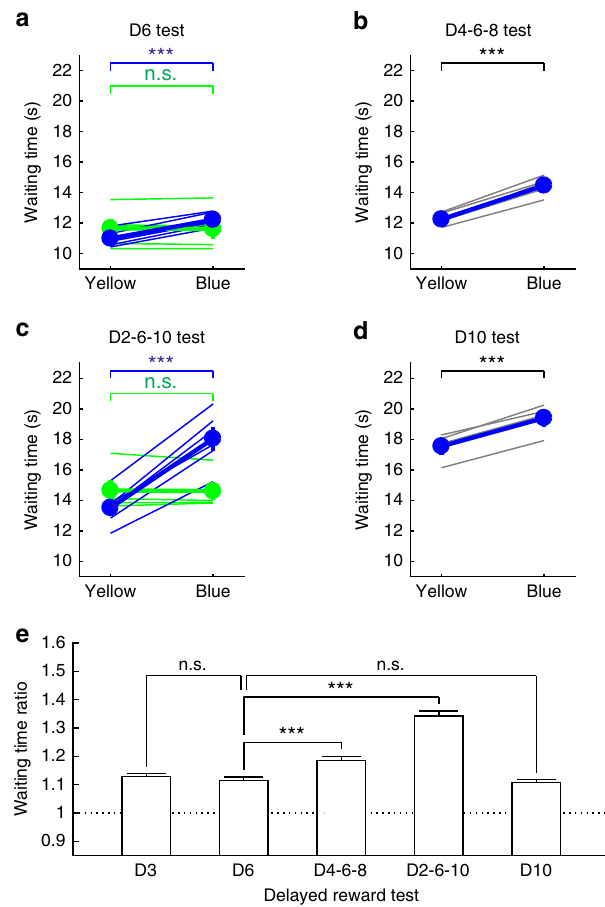
Fig. 6 The role of serotonin in promoting patience for future rewards with uncertain timing. a Average waiting time in serotonin no-activation (yellow) and activation (blue) during the D6 test for individual ChR2-expressing (blue thin lines) and WT (green thin lines) mice and for population of ChR2-expressing (blue line) and WT (green line) mice. b Average waiting time in serotonin no-activation (yellow) and activation (blue) during the D4-6-8 test for individual ChR2-expressing mice (gray lines) and for population of mice (blue line). c Average waiting time in serotonin no- activation (yellow) and activation (blue) during the D2-6-10 test for individual ChR2-expressing (blue thin lines) and WT (green thin lines) mice and for population of ChR2-expressing (blue line) and WT (green line) mice. d Average waiting time in serotonin no-activation (yellow) and activation (blue) during the D10 test for individual ChR2-expressing mice (gray lines) and for population of mice (blue line). *** P < 0.001 by paired t -test. Error bars represent the s.e.m. In some case, the error bars are too small to be visible. e Waiting time ratios in the 75% one-pellet tests in which food pellets were delivered with uncertain timing. The waiting time ratio in the D2-6-10 test was the largest among the fi ve tests. The waiting time ratio in the D6 test was not signi fi cantly different from the waiting time ratios in the D3 test and in the D10 test. *** P < 0.001 by post hoc Bonferroni correction. Error bars present the s.e.m. n.s. not signi fi